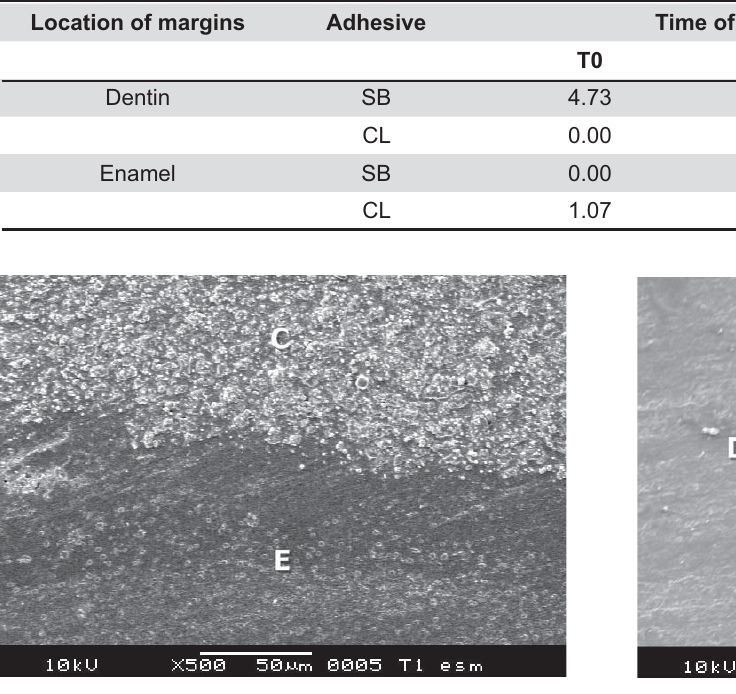
Figure 3- Photomicrography obtained at T0 showing the presence of gap in the dentinal margin of a restoration performed with Single Bond 2. D – dentin; C – Composite